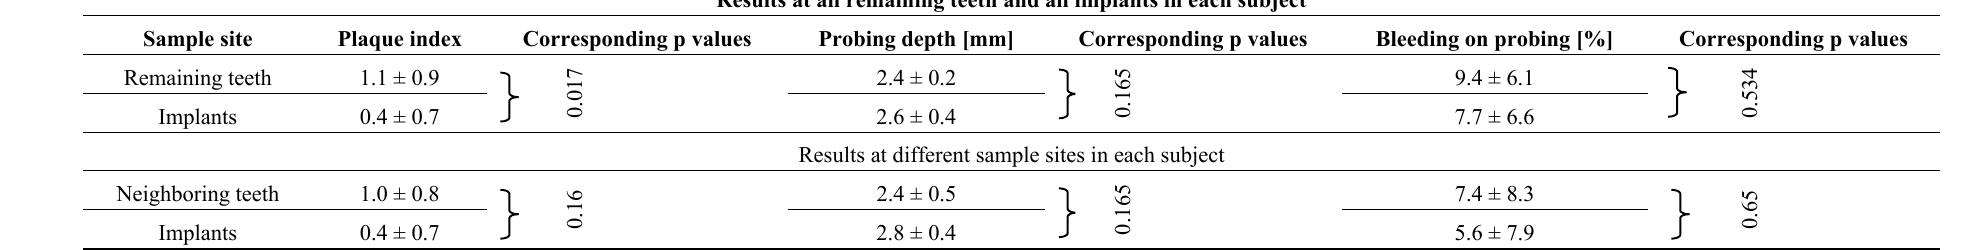
Table 3. Patients with healthy tissues around teeth and implants: plaque index, probing depth and bleeding on probing at implant or tooth sites (mean and standard deviation) and corresponding p